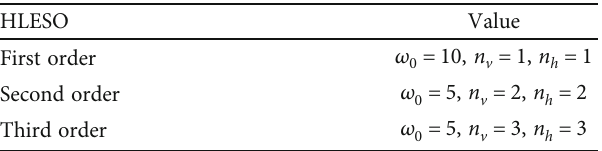
Table 4: The design parameters of HLESO.